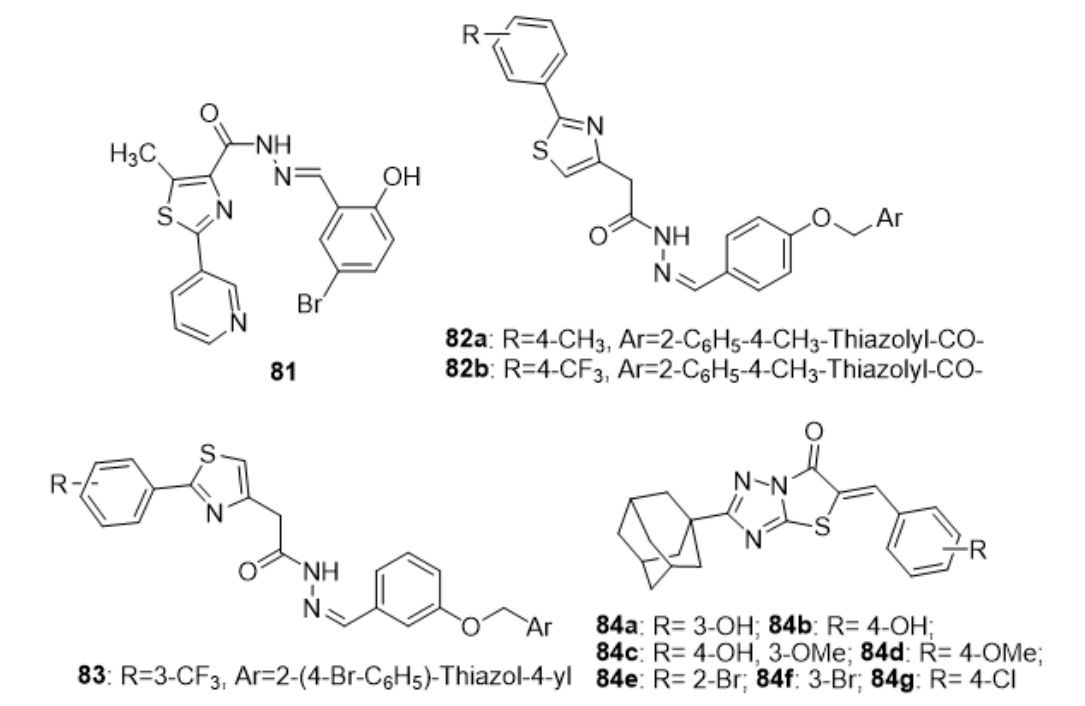
Figure 7. Recently designed and synthesized thiazoles as potential anti-inflammatory agents.